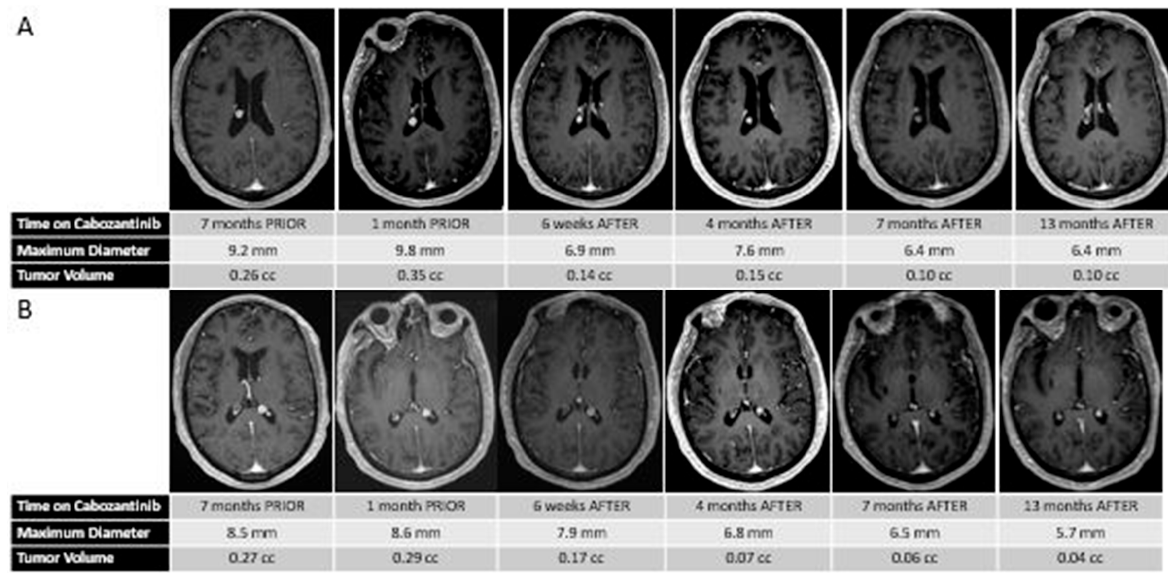
Figure 1. ( A ) Sequential MR images demonstrating the changes in size and volume of the right putative intraventricular meningioma before and after treatment with cabozantinib. ( B ) Sequential MR images demonstrating the changes in size and volume of the left putative intraventricular meningioma before and after treatment with cabozantinib.